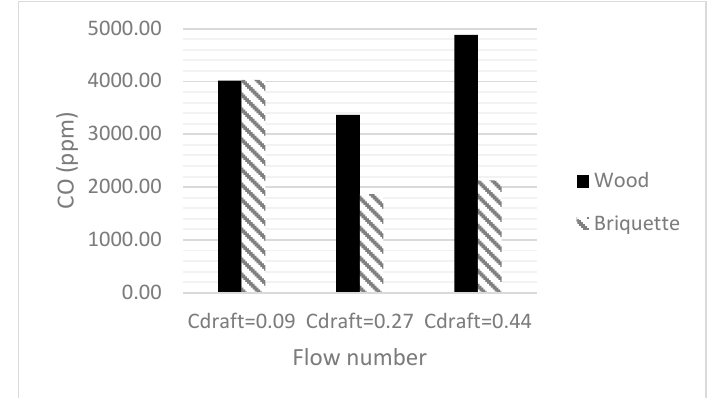
Figure 9. Average CO emissions for different fuels .